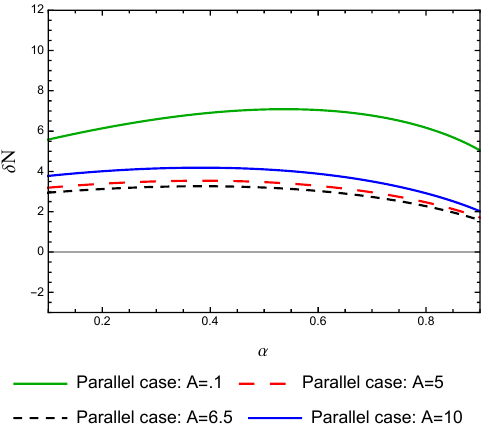
Figure 9 . Parallelly accelerating detectors in (1 + 3) D: δ N VS α plot for different fixed values of A with ∆ E B = 1 . a B